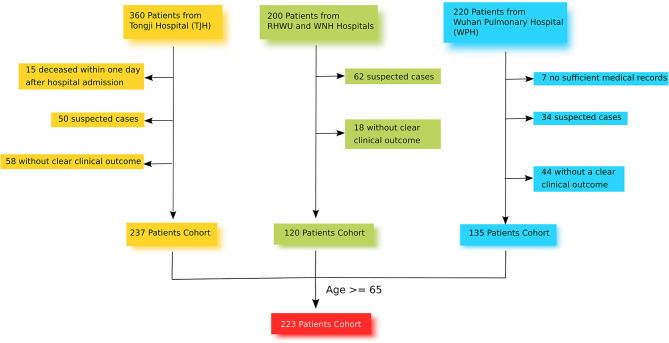
Study Design Chart.